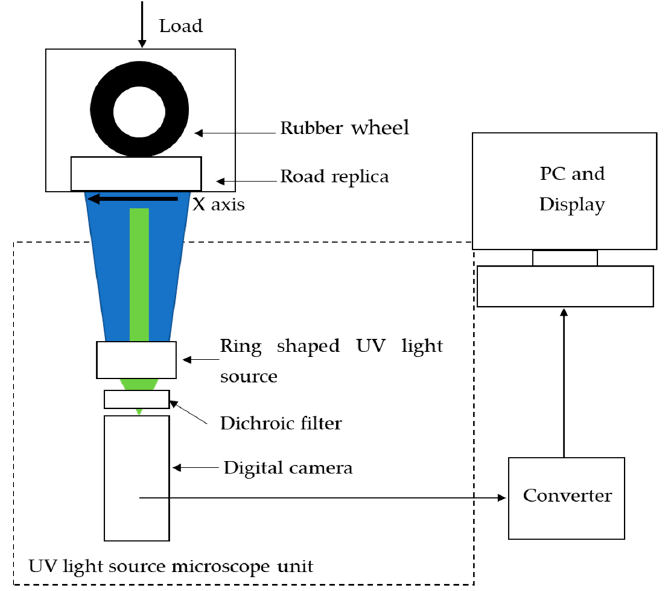
Figure 2. Outline of Observation system.